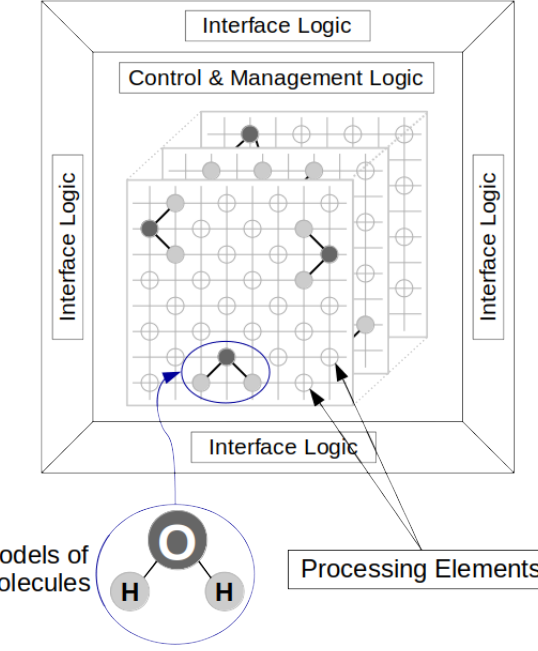
Figure 2. Block diagram of DSlave